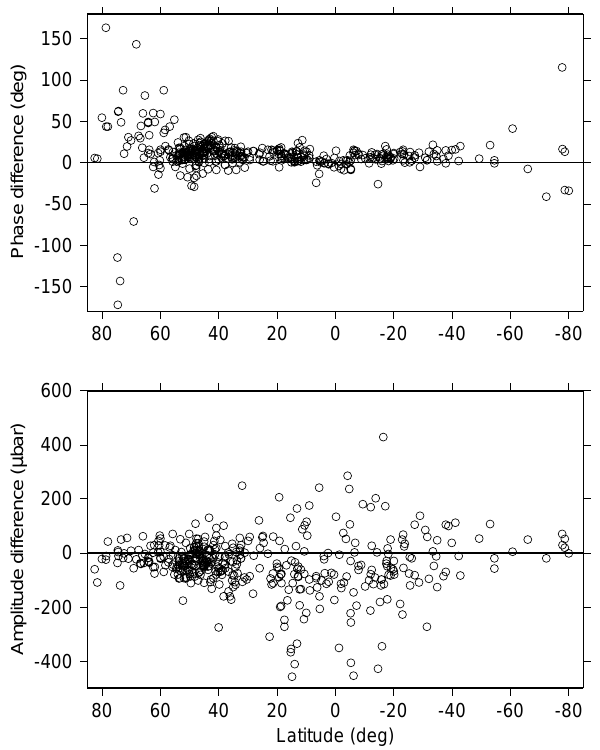
Fig. 6. Amplitude and phase differences between ECMWF-implied S 2 (p) tide and estimates based on 428 barometer stations. A small systematic error in the phases is readily apparent.